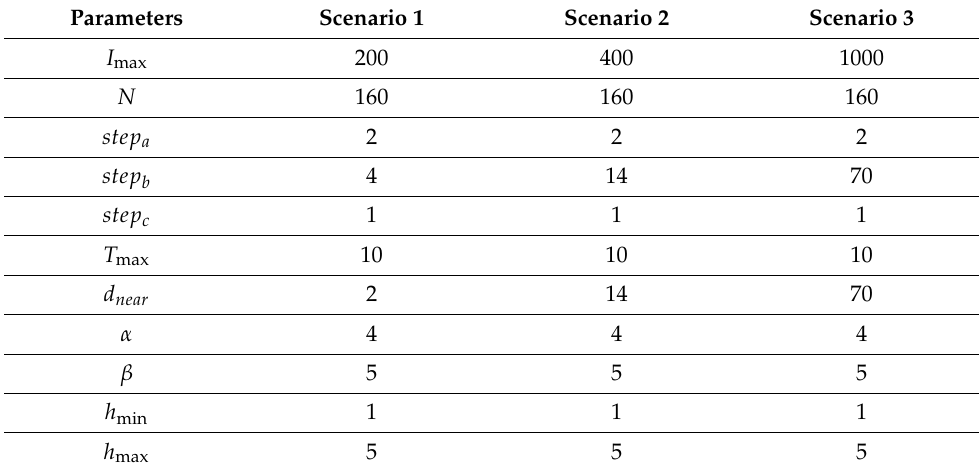
Table 2. Parameters of WPA in three scenarios.